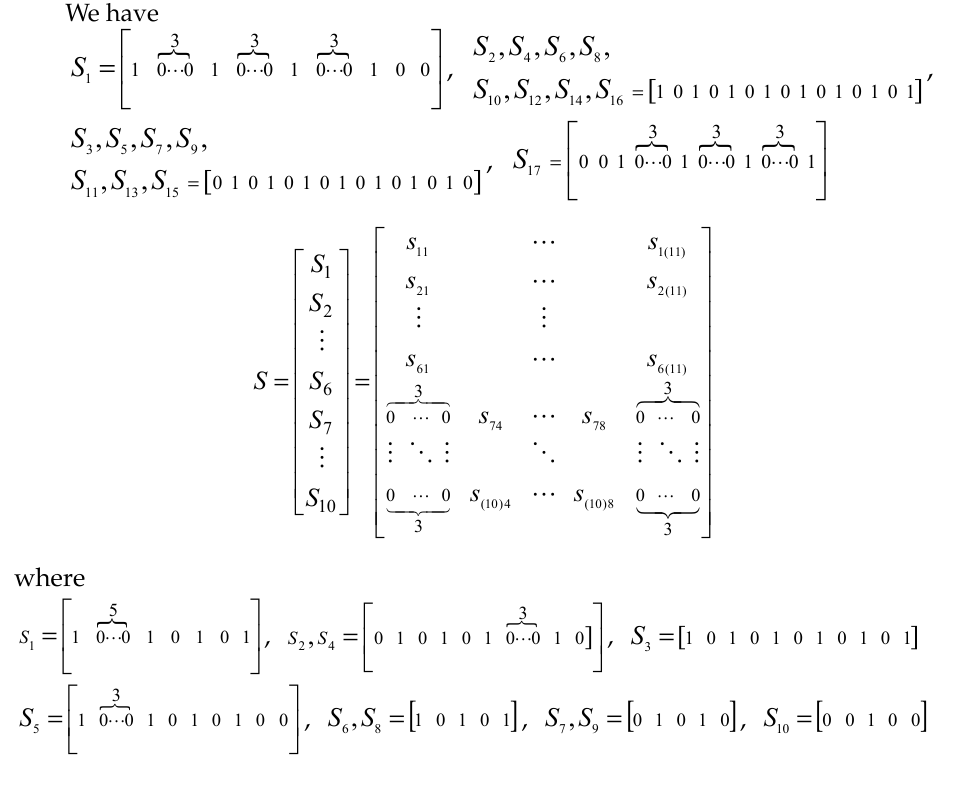
Figure 9. Three-track combination of 484 cross-break track and its